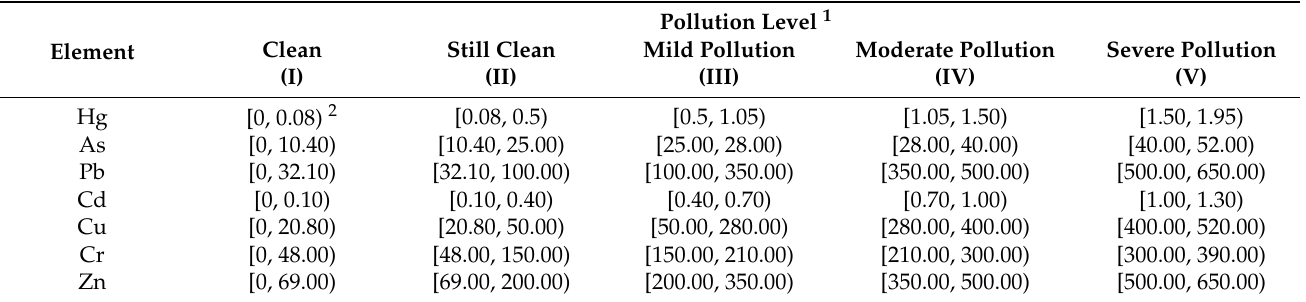
Table 1. Evaluation standards for the pollution of cultivated soils by potential toxic elements in the study region